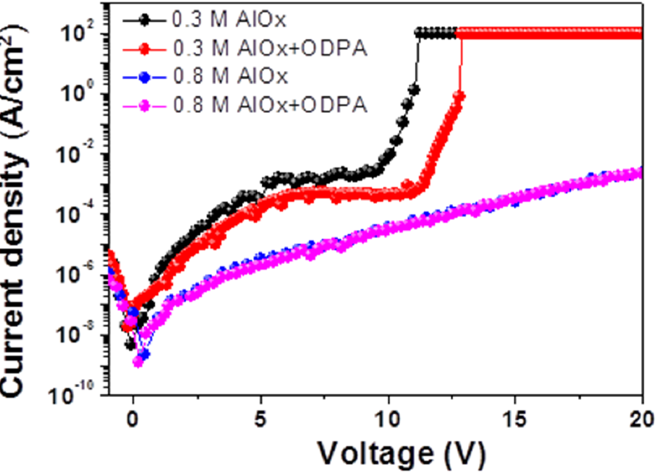
Figure 3. Leakage current characteristics of Au ‐ AlO x /ODPA ‐ Cr/glass devices with 0.3 ‐ and 0.8 ‐ M AlO x sol ‐ gel concentrations.